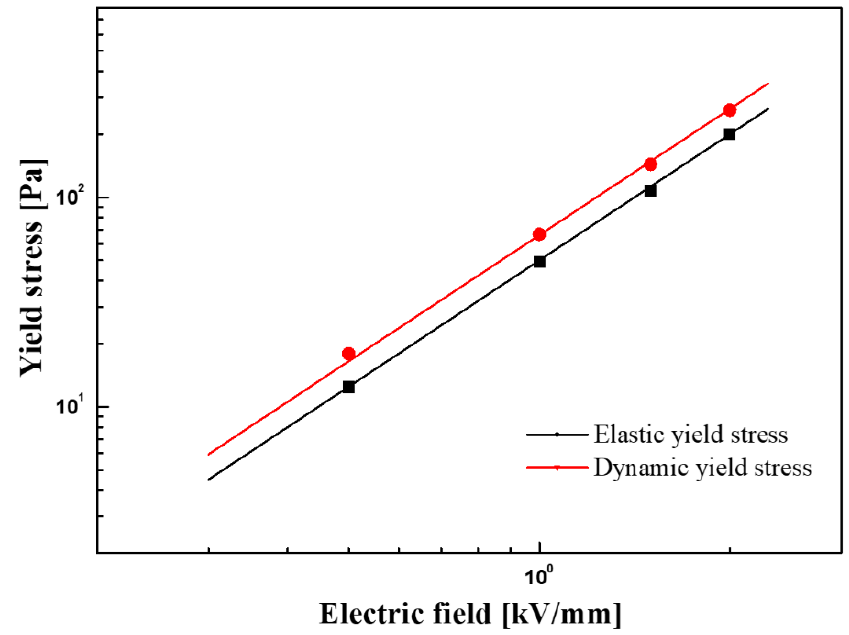
Figure 11. Dynamic and elastic yield stresses of the core–shell particle (10 vol%)-based ER suspension as a function of an electric field.